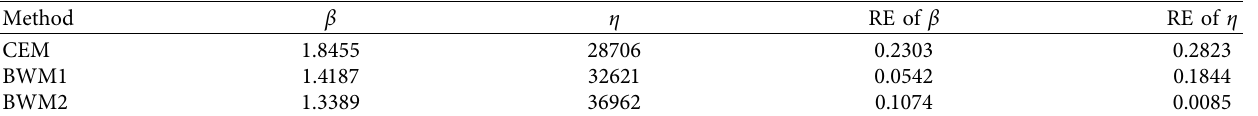
Table 4: Comparison of calculation